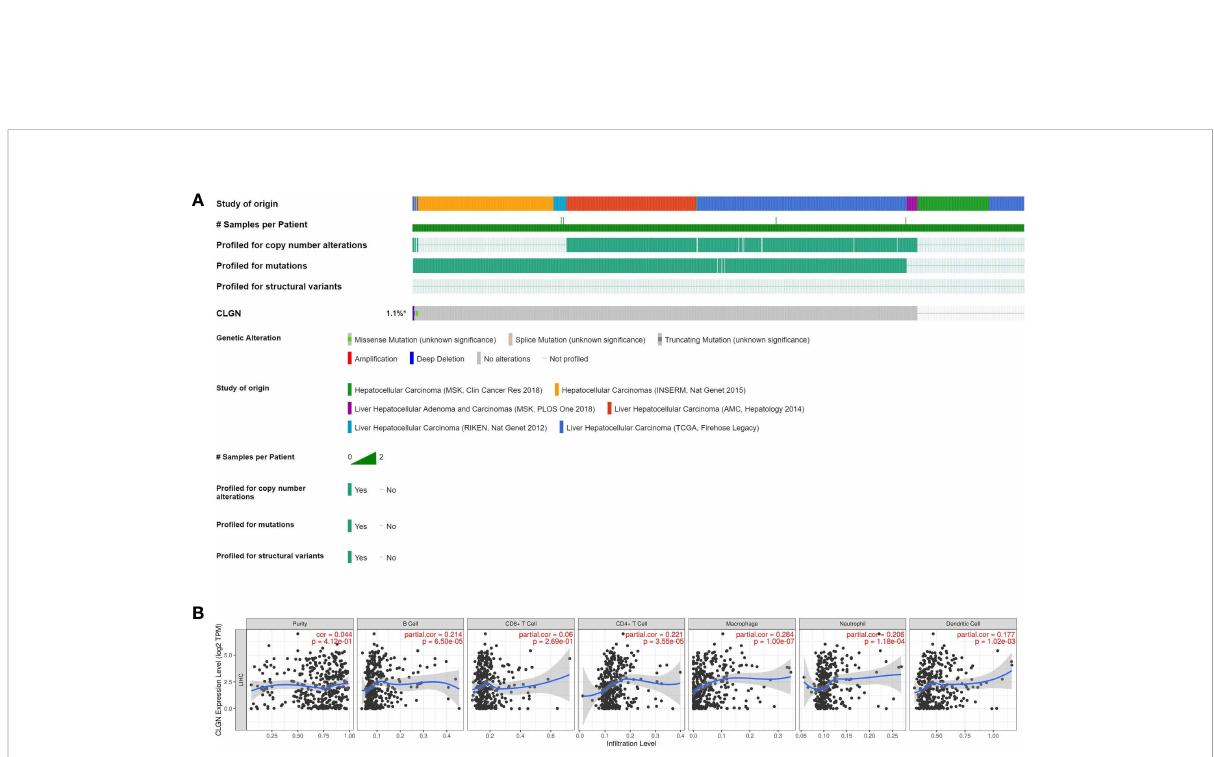
FIGURE 8 CLGN mutations in HCC patients and the correlation between CLGN expression and tumor in fi ltrating lymphocytes. (A) CLGN mutations occurred in 10 (< 1%) of 1089 patients from six data sources (CBioportal). (B) There is no signi fi cant correlation between the mRNA of CLGN and the in fi ltrating levels of B cells, CD4+ T cells, CD8+ T cells, neutrophils, macrophages, and dendritic cells in HCC, COR < 0.5